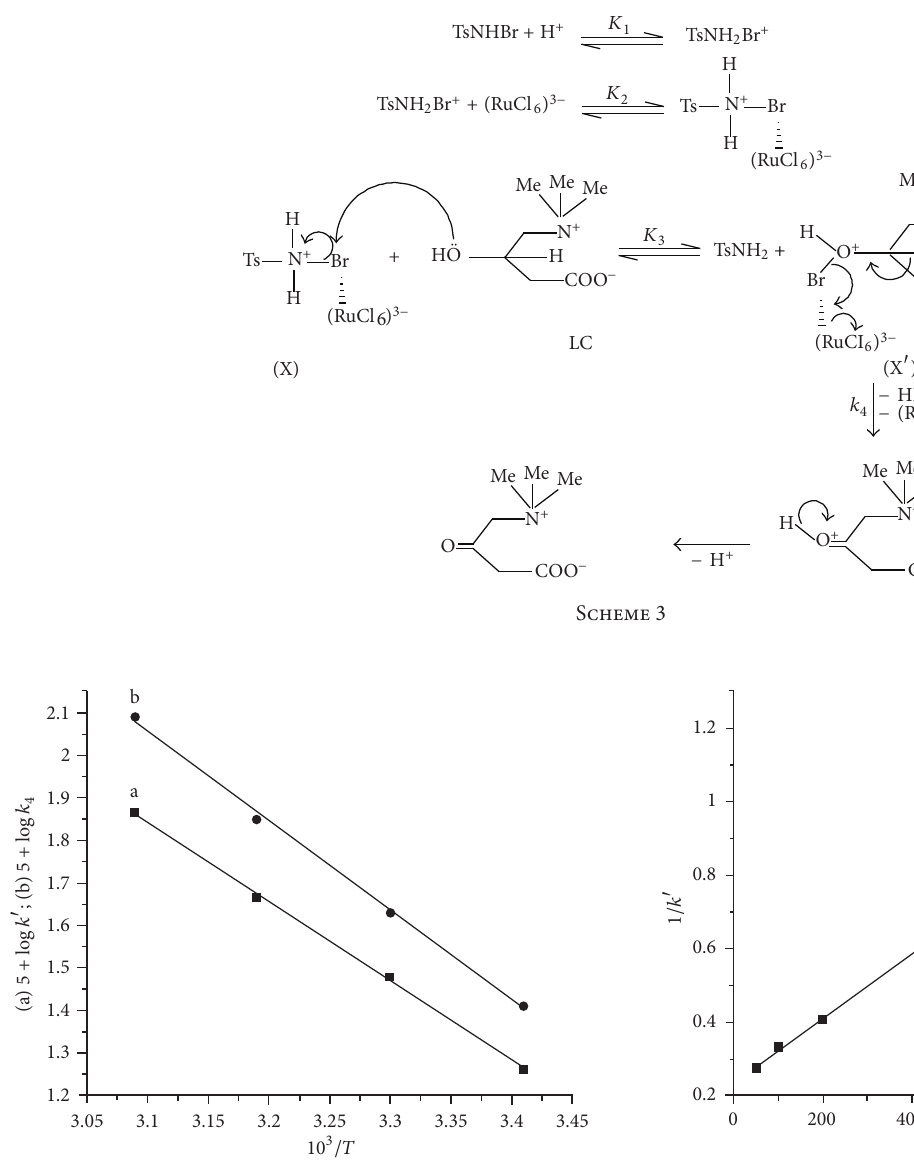
F 3: Plot of10 F 4: Double reciprocal plot of 1/[LC] versus 1/